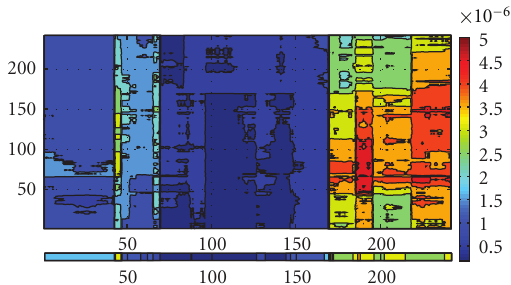
Figure 3: Above: coe ffi cient of 4th-order of the potential associated with the pdf using 242 di ff erent EOF patterns (first EOF of preindustrial run in sliding periods of 100 years) to project the pre- industrial run. Horizontal axis: same as in Figure 2. Vertical axis: starting year of the period for the calculus of the EOF. Below: shows, for comparison, same data plotted in Figure 3 (i.e., using EOF calculated with the 20th-century run: